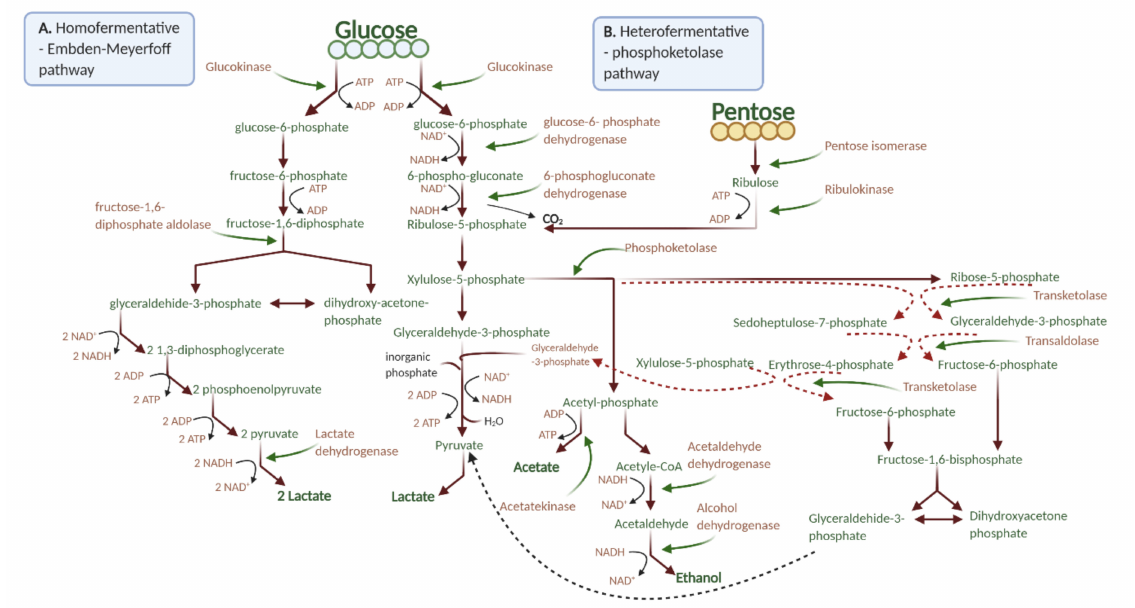
Figure1. Glucosefermentationpathway. ( A )Homofermentativemetabolism(throughEmbden–Meyerhoff pathway); ( B ) heterofermentative metabolism (phosphoketolase pathway) (image created using BioRender application https: //